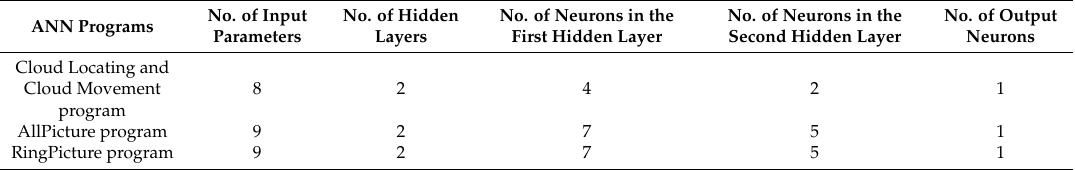
Table 2. The neural network structure used to carry out this